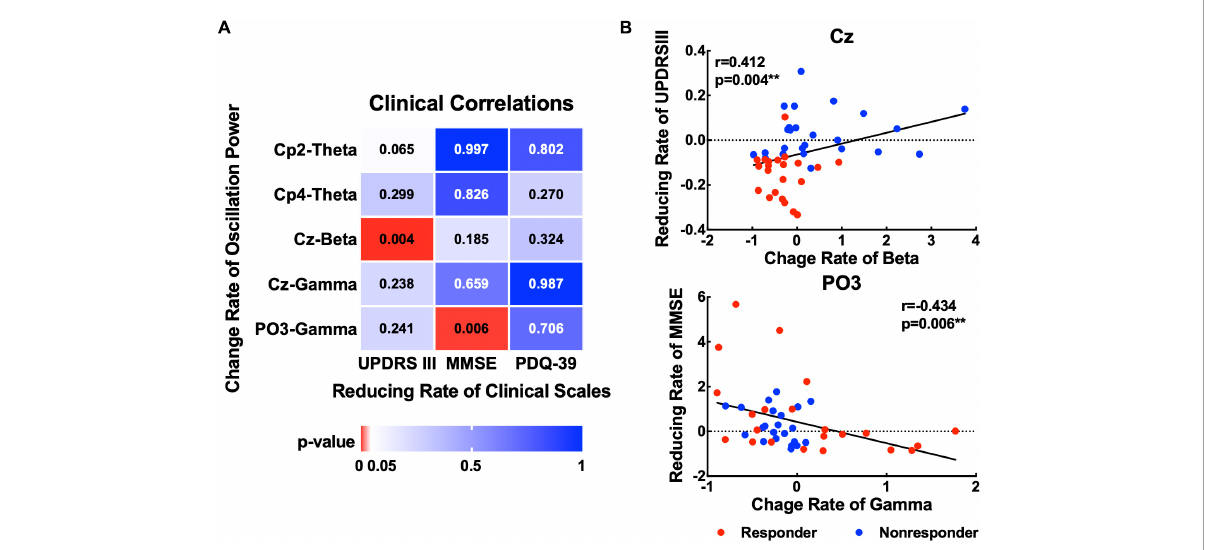
FIGURE5 Association between changes in oscillatory power and clinical scales. (A) The p -values for the correlations between the change rate of the oscillatory power (theta, beta, and gamma) with significant changes and three kinds of clinical scales (UPDRS III, MMSE, and PDQ-39). (B) Scatter plots show significant correlations between the rate of change of beta power in the Cz electrode and the rate of change of gamma power in the PO3 electrode with MMSE. ** p < 0.01 with